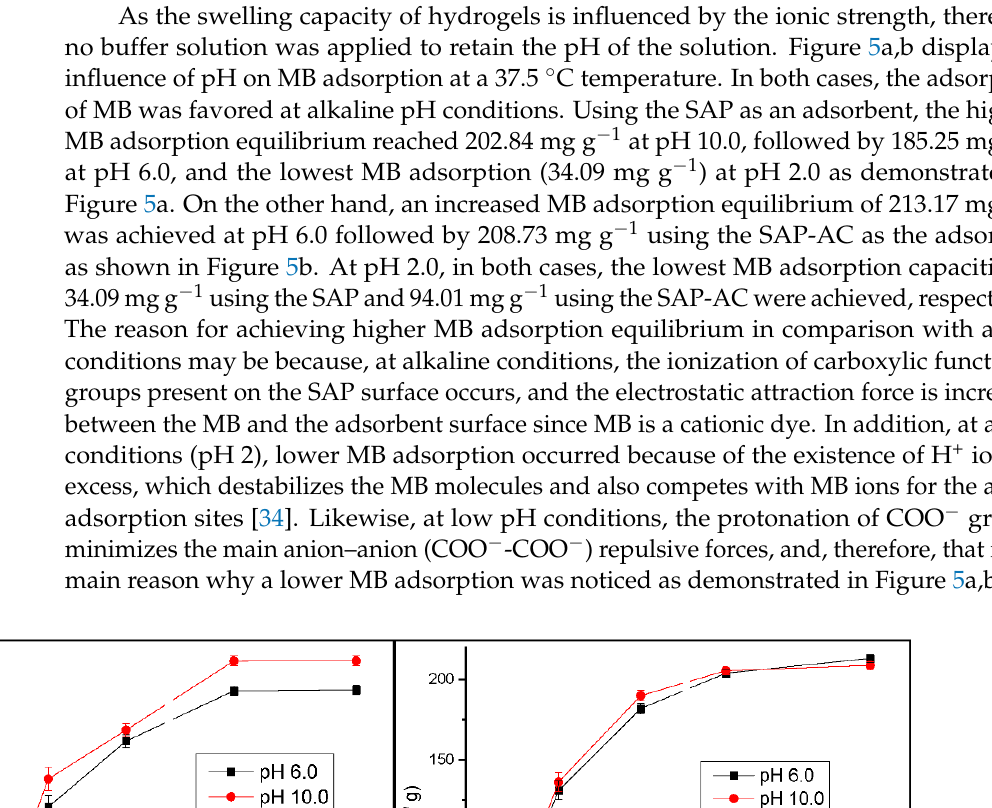
Figure 4. MB adsorption as a function of time at pH 6.0 and 37.5 o C using ( a ) SAP and ( b ) SAP-AC as adsorbents.